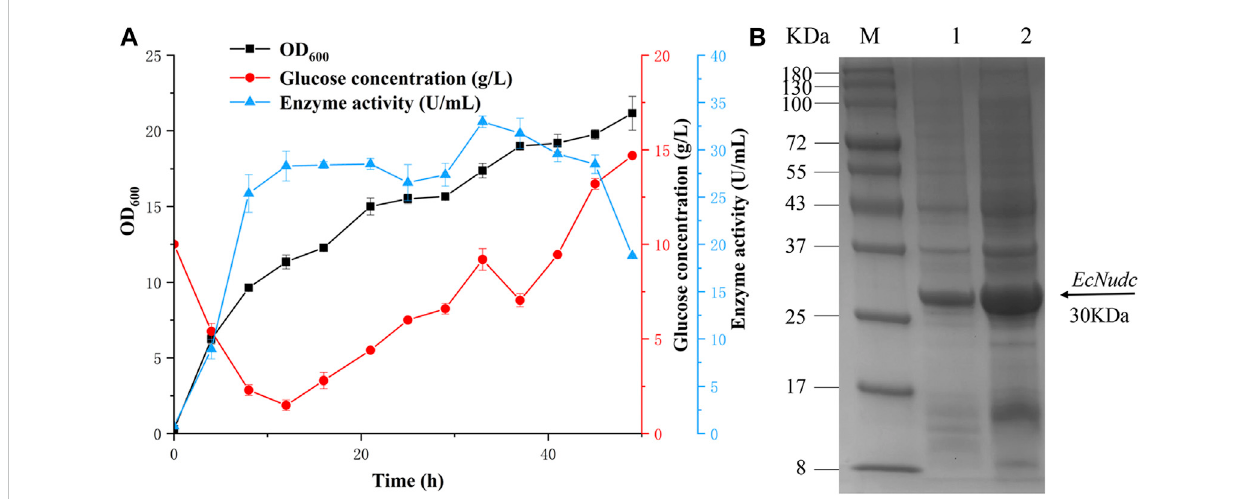
FIGURE 9 Fermentationcurveof EcNudc-M andSDS-PAGEanalysis ofrecombinant EcNudc expression. (A) Fermentationcurveof EcNudc-M underconstant